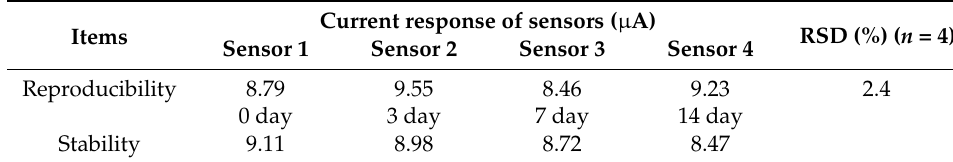
Table 2. Data results of reproducibility and